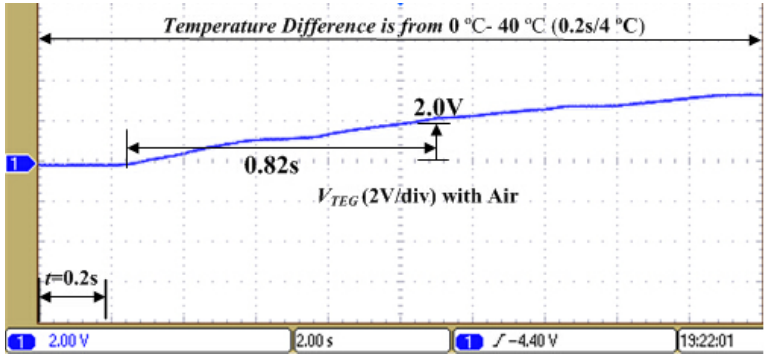
Figure 10. Photograph of the mimicked board.